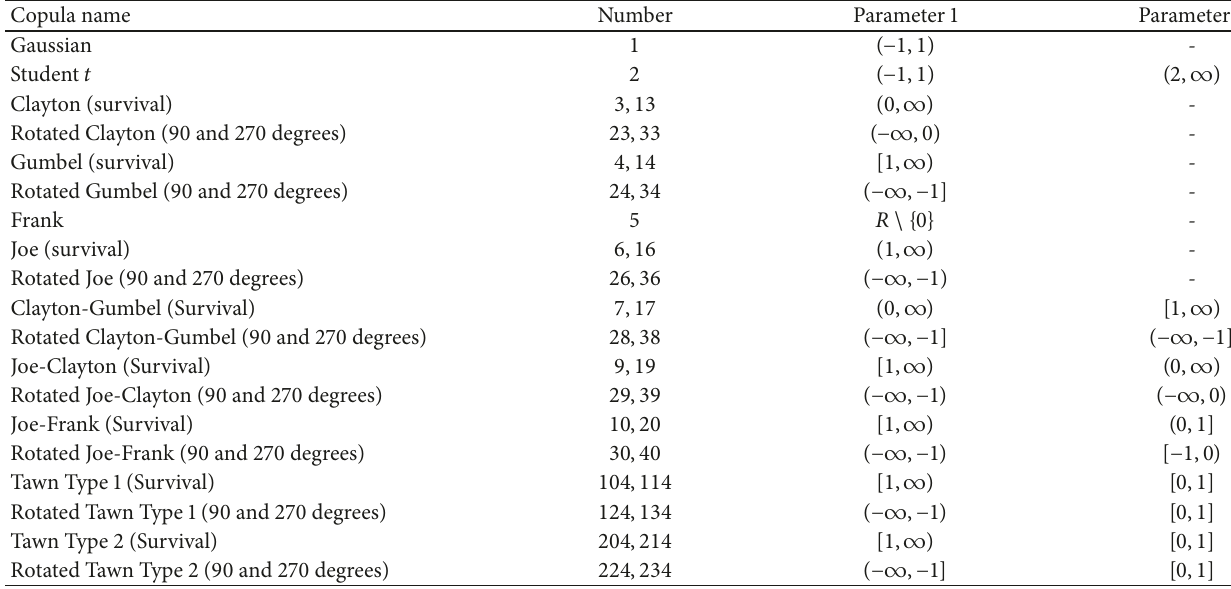
Table 16: Bivariate copula families with which the Hybrid Clayton-Frank copula is